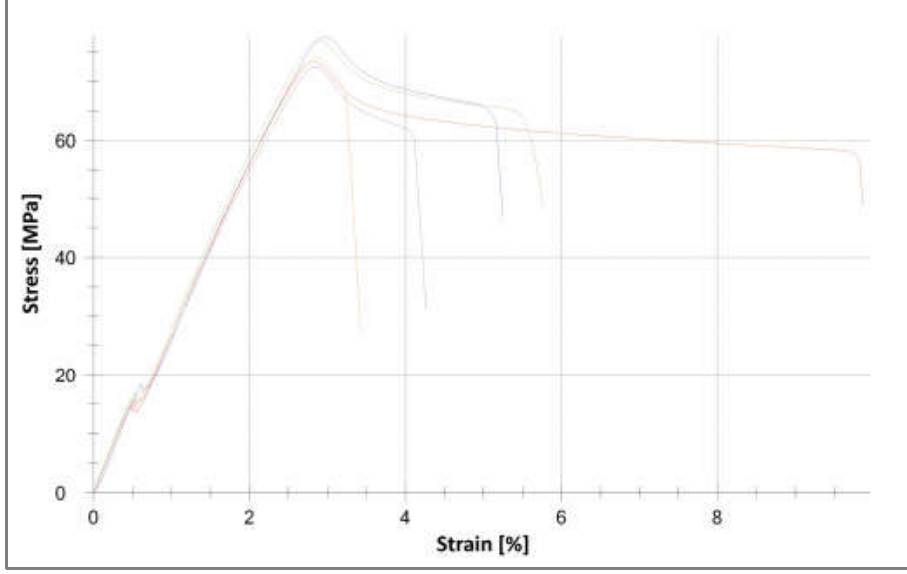
Figure 9. Stress-strain curves of plasma modified PLA with gases mixtures 50% Ar + 50% O 2 (lines correspond to 5 sample measurements).